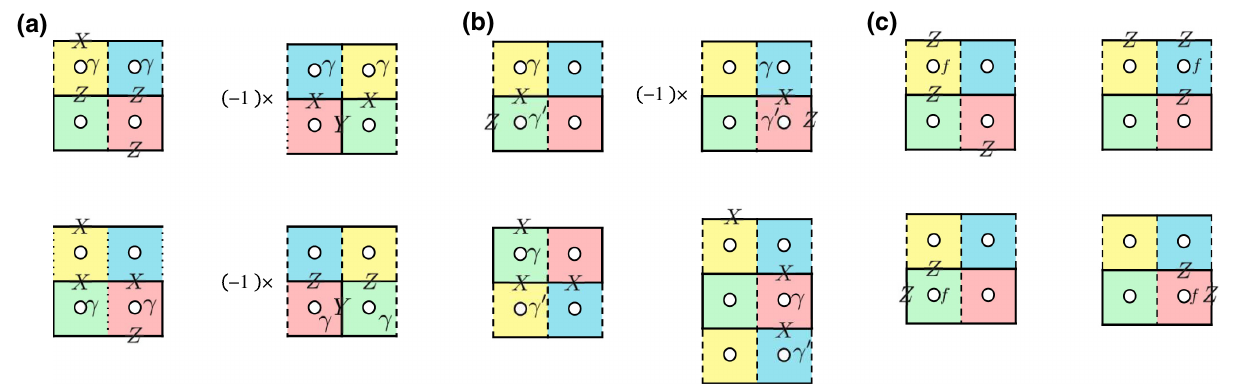
FIG. 9. Shorthand representation of the mapping between fermionic operators and the Pauli matrices. Panel (a) represents the nearest-neighbor horizontal hopping terms. The first diagram indicates that i γ yellow γ blue is mapped to the Pauli operator XZZZ indi- cated above. The second diagram (top right) represents that i γ blue γ yellow is mapped to − XXY . The remaining diagrams follow the same rule, e.g., i γ green γ red ↔ XXXZ and i γ red γ green ↔ − ZZY . Panel (b) represents the near-neighbor vertical hopping terms. Note that the fermionic hopping term is γ to γ (cid:7) in this case. For example, the first diagram is i γ yellow γ (cid:7) parity operators. Each face f indicates the location of the on-site fermionic parity operator − i γ f γ (cid:7) shown in the